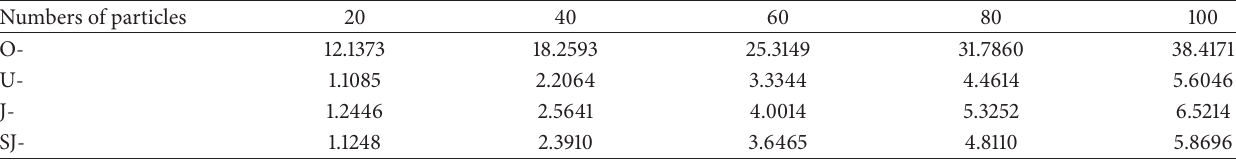
Table 4: Computational time (sec) using different numbers of particles.